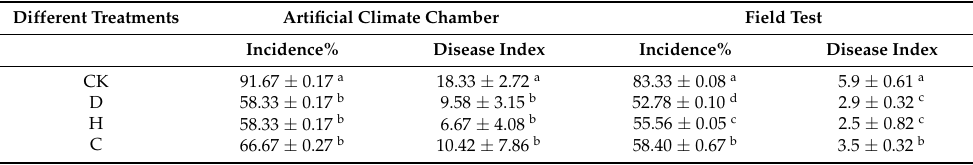
Table 1. Evaluation of Fusarium wilt in an artificial climate chamber and field test in Faba